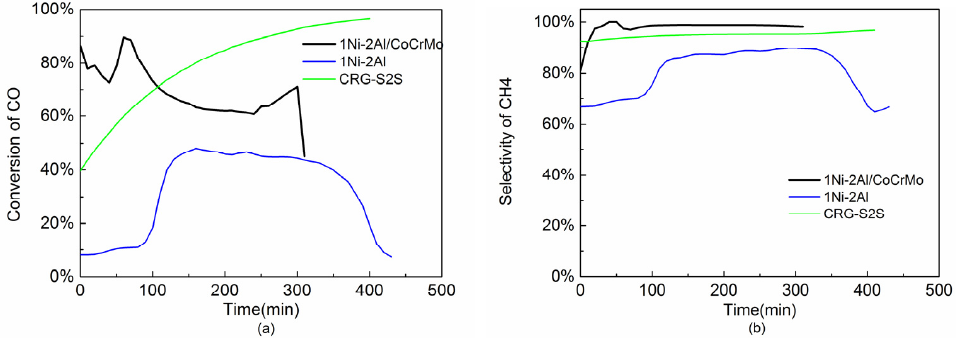
Figure 9. ( a ) Conversion of CO for 310 min. ( b ) Selectivity of CH 4 for 310